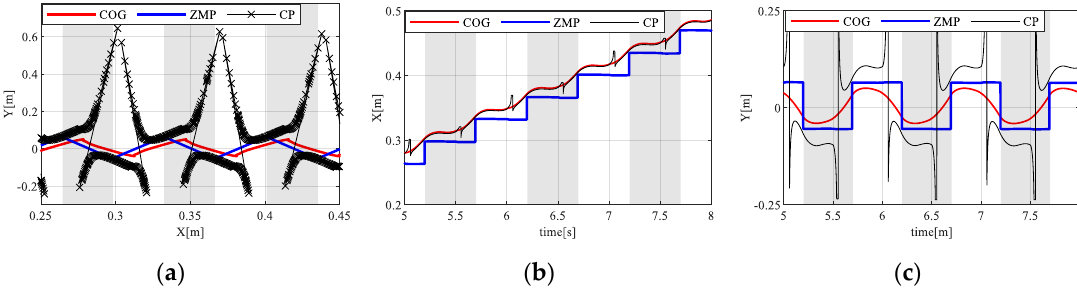
Figure 5. Results of stability indices and CP detected from the robot walking simulation (red line: COG, blue line: ZMP, and black line: CP): ( a ) Traces of stability indices and the CP in xy -axis; ( b ) results of stability indices in x -axis (walking forward); ( c ) results of stability indices and the CP in y -axis (toward left and right).